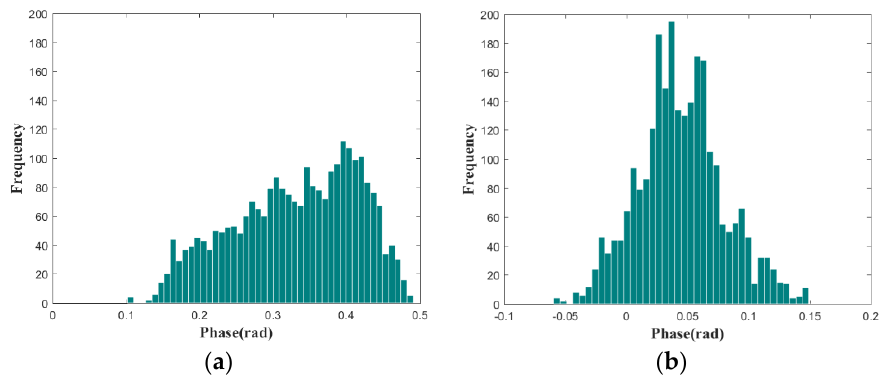
Figure 7. Histograms of the atmospheric phase residuals: ( a ) linear model method and ( b ) our proposed method.